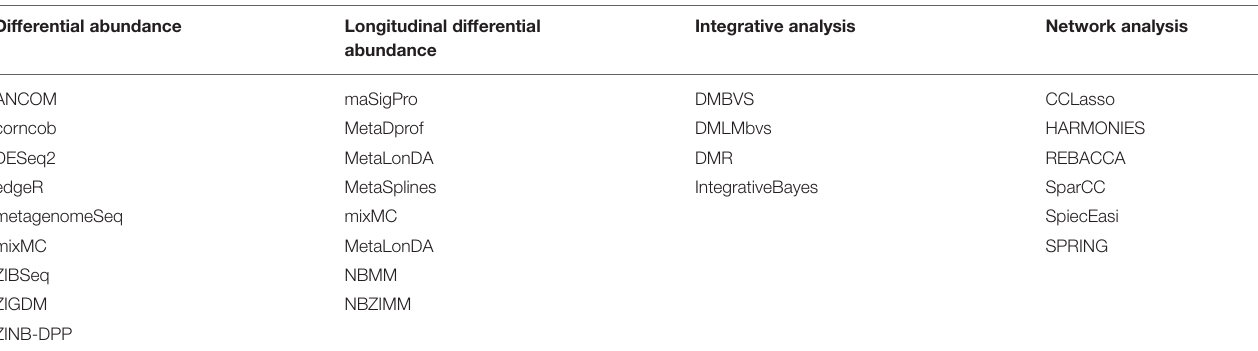
TABLE 2 | Classes and alphabetized methods of statistical analyses discussed in this paper.